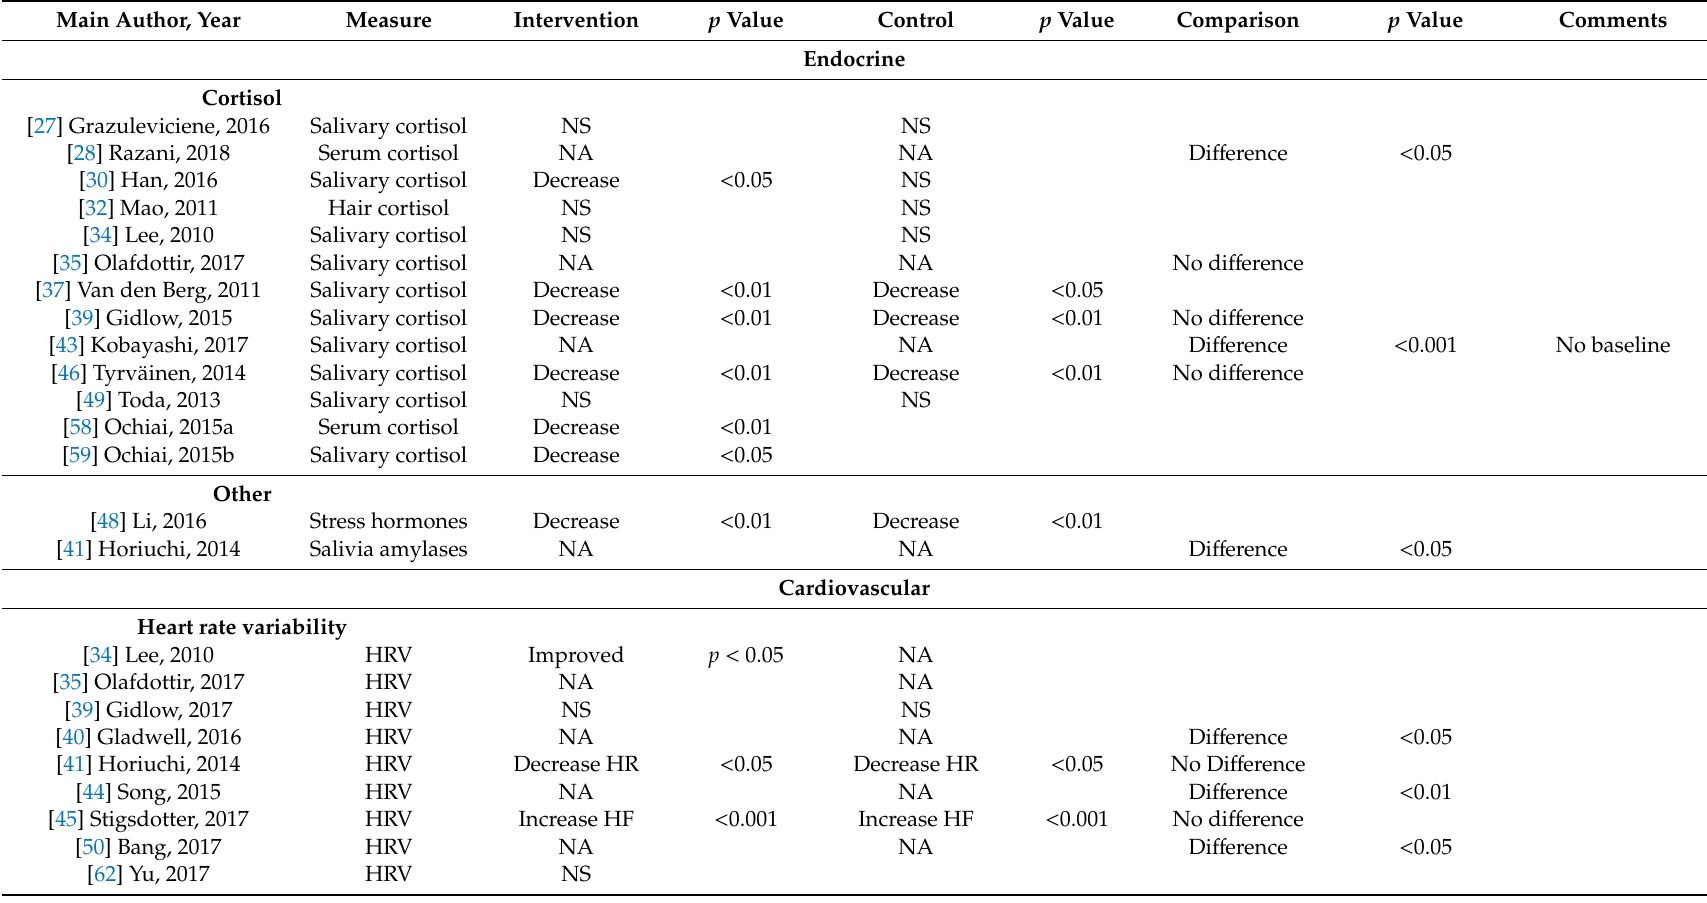
Table 4. Overview of physiological measures and e ff